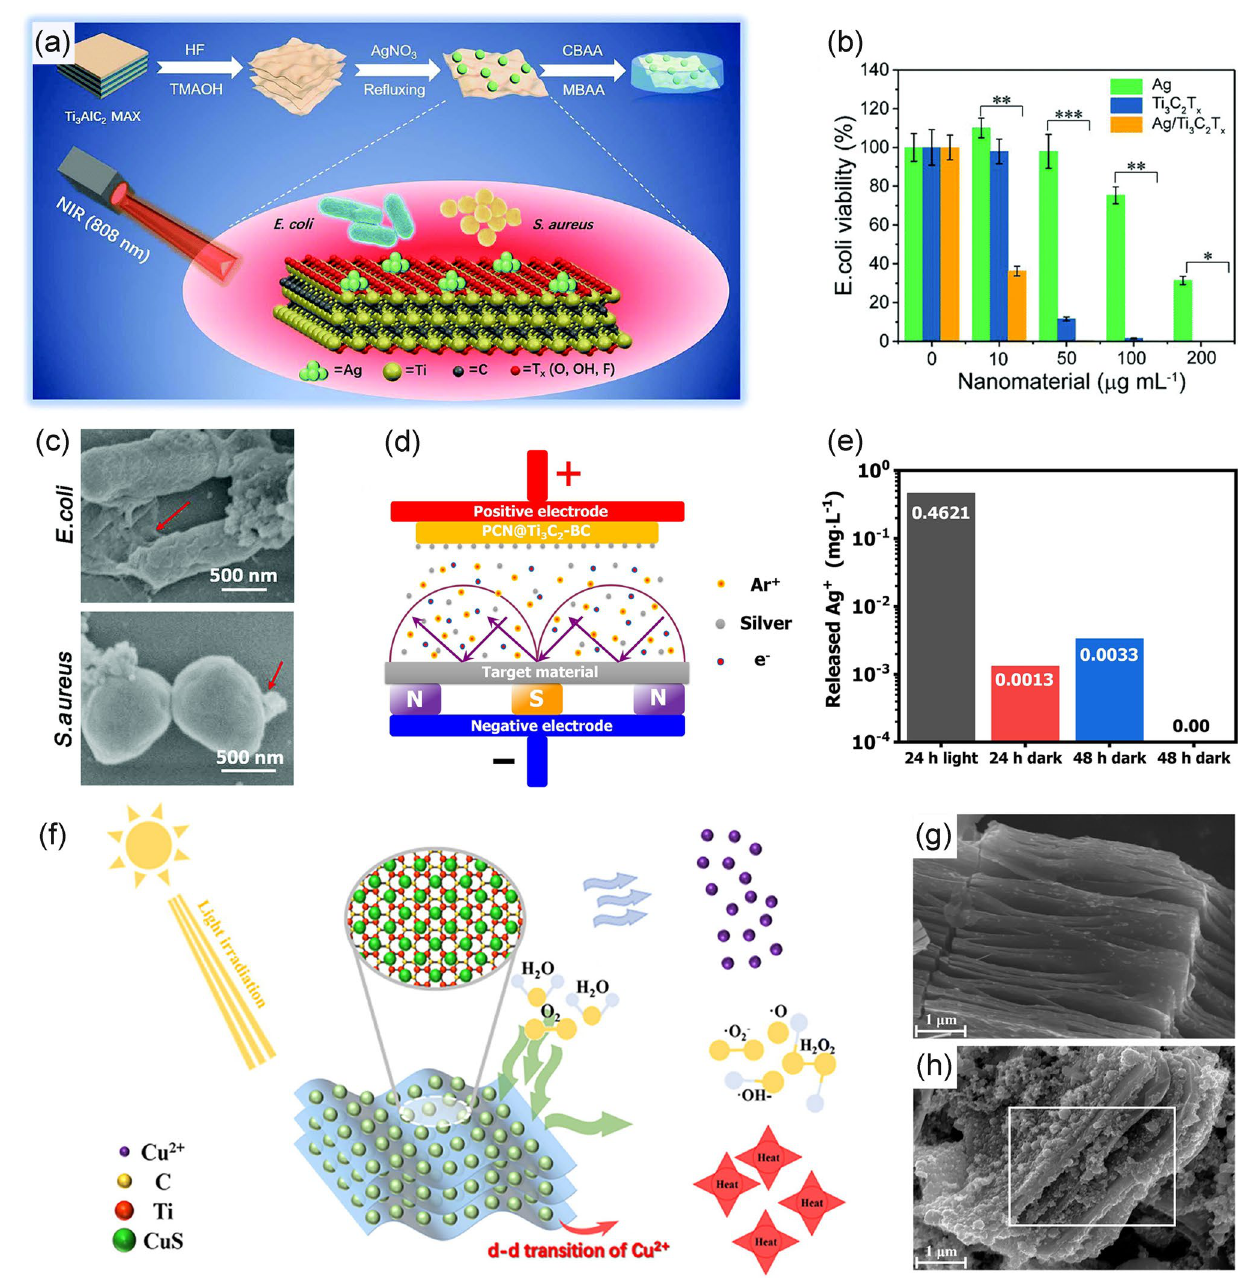
Fig. 9 a Schematic illustration of photothermal antibacterial properties of Ag/Ti 3 C 2 T x ; b Relative bacteria viability with NIR light irradiation after incubation with different concentrations; c HRTEM images of E. coli and S. aureus were treated with Ag/Ti 3 C 2 T x under NIR light [41]. Copyright 2020, Royal Society of Chemistry. d Schematic illustration of the film loaded with Ag + ; e Schematic illustration of the release of Ag + under different treatments [143]. Copyright 2021, Elsevier. f Schematic illustration of antibacterial mechanism of Ti 3 C 2 T x /CuS; g SEM image of multilayered